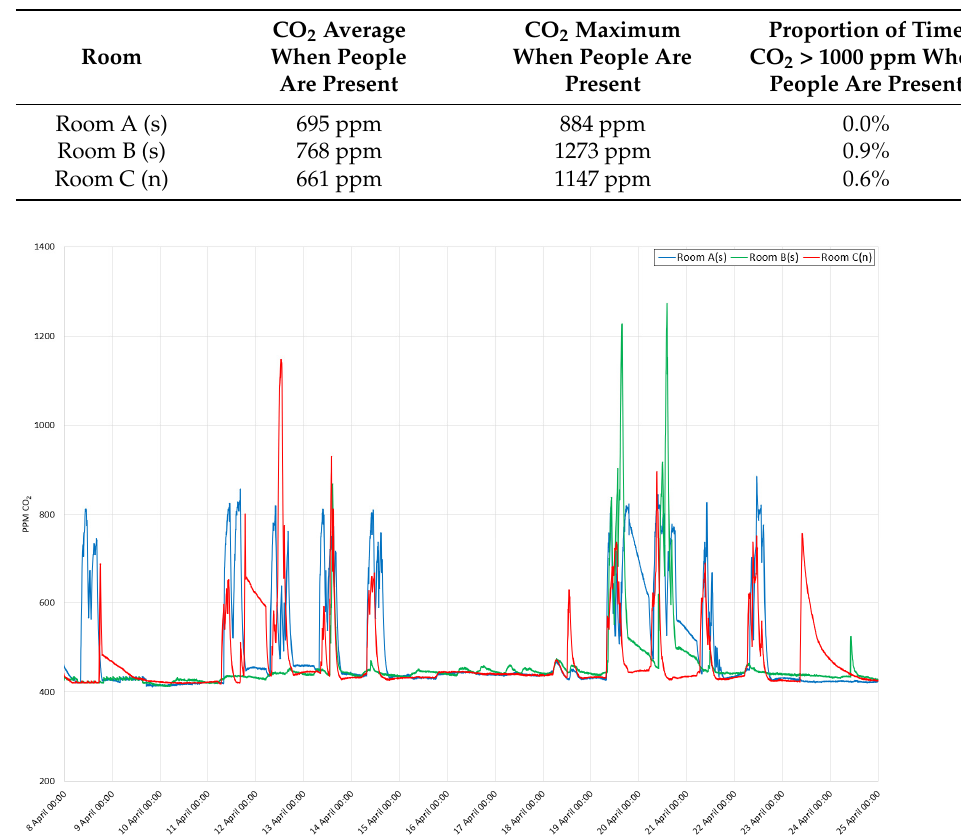
Figure 29. Results for CO 2 measurements during April 8 –24 for Rooms A(s), B(s), and